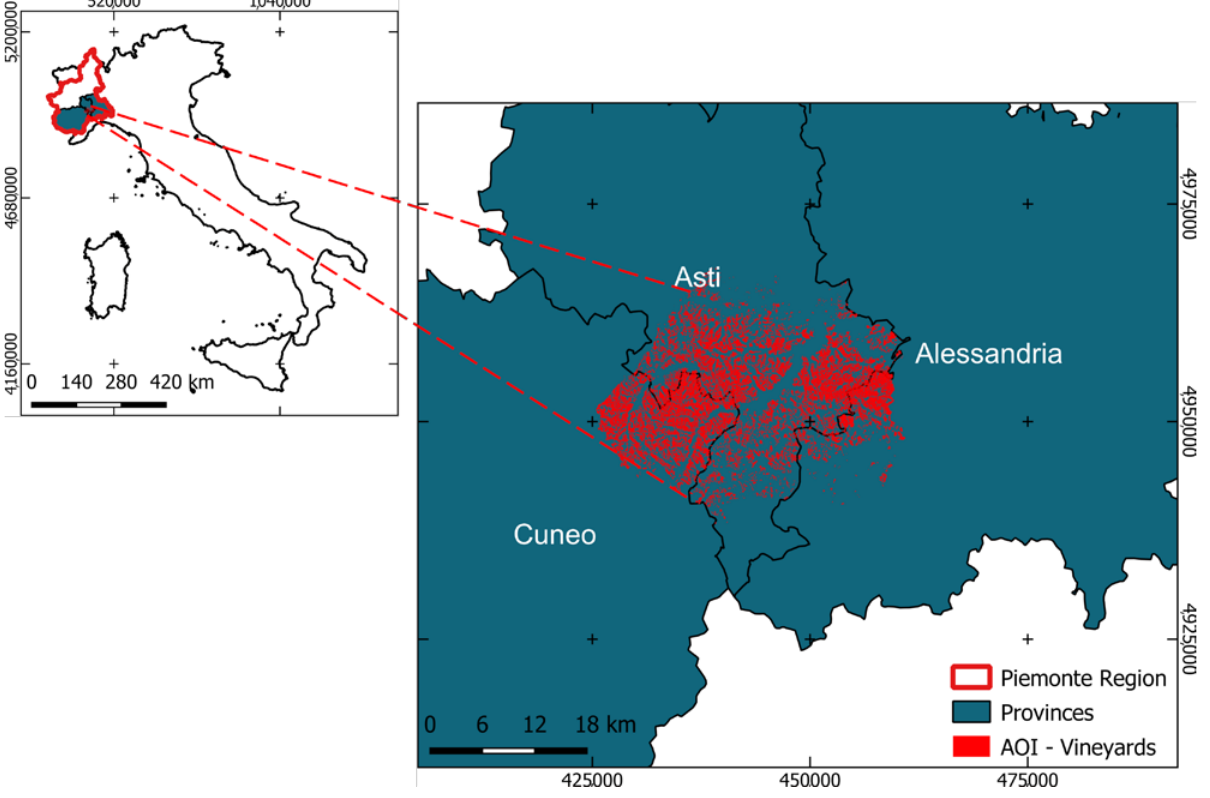
Figure 1. AOI and vineyard distribution in the study area (Piemonte, NW-Italy). Reference frame is WGS 84 UTM zone 32N (EPSG: 32,632).